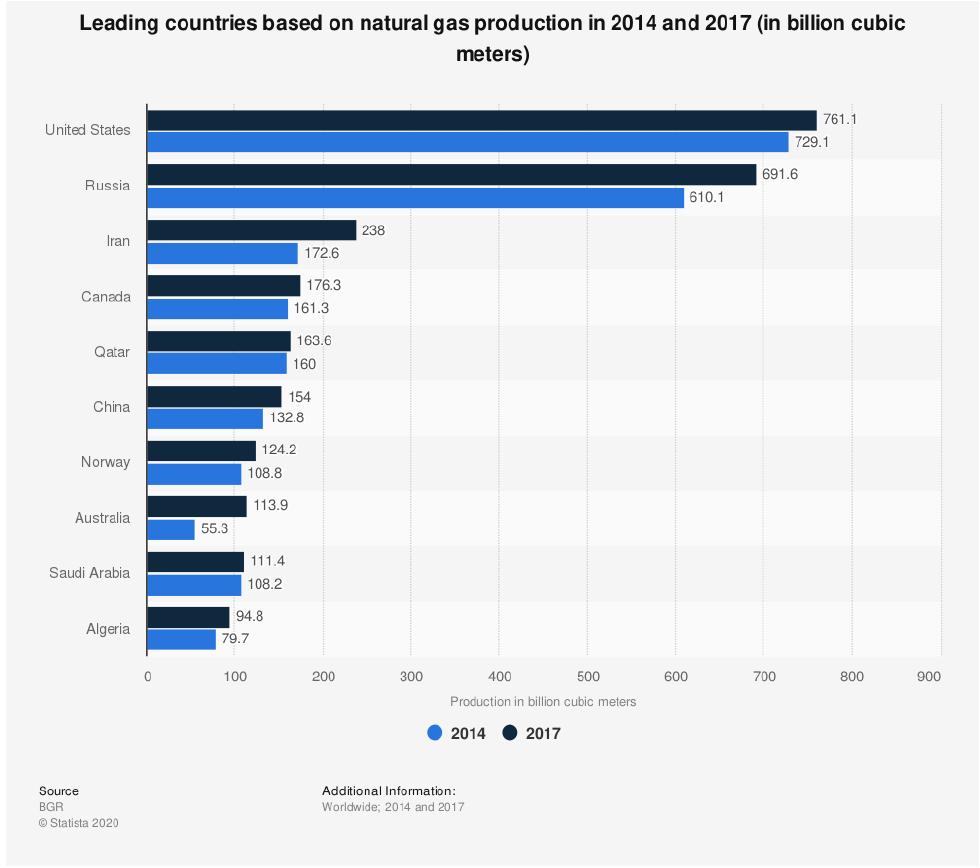
Figure 2 . Leading countries based on natural gas production in 2014 and 2017. Reproduced from, [18], Statista: 2020.